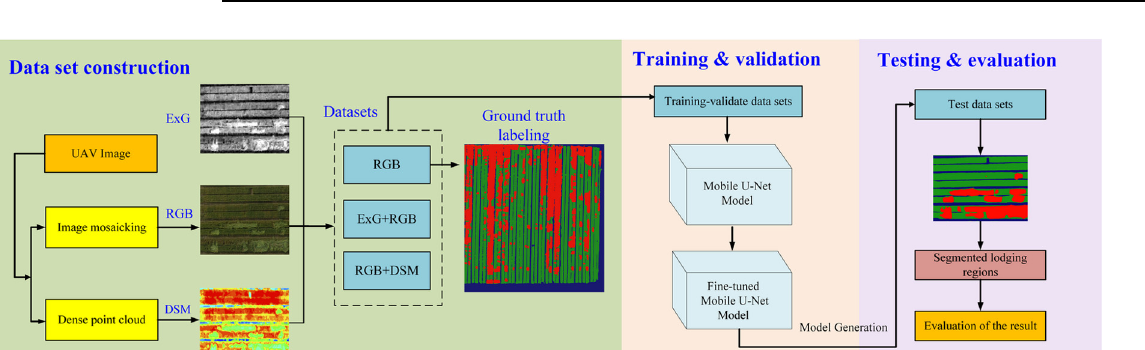
Figure 4. The technical flow chart of this